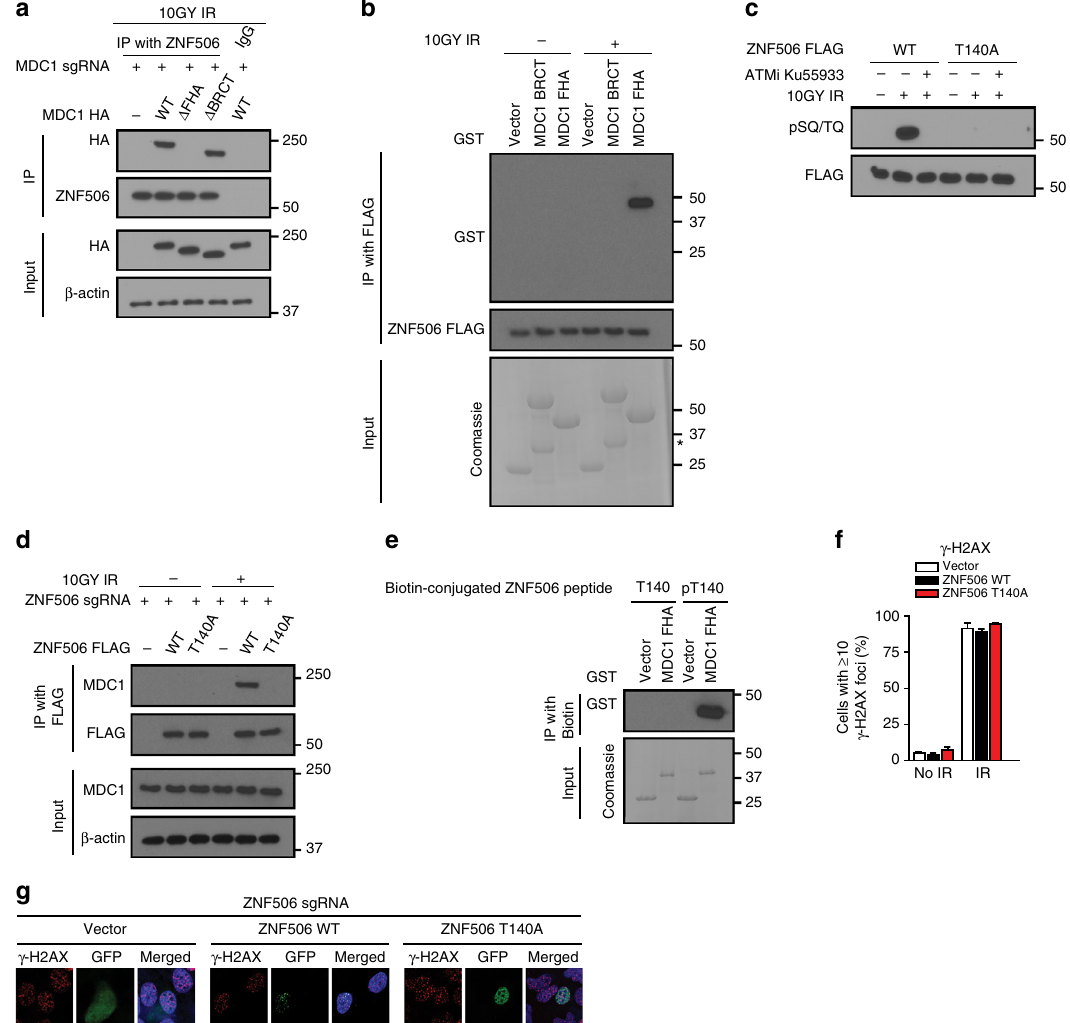
Fig. 2 DNA damage-induced ATM-dependent phosphorylation of ZNF506 is required for its MDC1-mediated recruitment to the DNA double-strand break site. a ZNF506 interacts with the FHA domain of MDC1 upon DNA damage. Deletion of the FHA domain ( Δ FHA) abrogates the interaction between MDC1 and ZNF506 in HEK293 cells. MDC1 knockout cells were transfected with the indicated plasmids and exposed to radiation. An hour later, interaction between endogenous ZNF506 and MDC1 fragments were assessed. b ZNF506 interacts with the FHA domain of MDC1 in vitro. c ATM phosphorylates ZNF506 at the T140 residue in HEK293 cells following DNA damage. ATM inhibitor (ATMi) KU55933 was used as a control. Cells were transfected with the indicated tagged constructs, co-immunoprecipitation was performed, and the blot was probed with pSQ/TQ antibody. d Phosphorylation of ZNF506 is required for its interaction with MDC1. Endogenous ZNF506 was knocked out in HEK293 cells using CRISPR and the indicated FLAG-tagged constructs were expressed. Cells were exposed to the indicated doses of radiation. Lysates were collected after an hour and immunoprecipitation with FLAG was performed. Blots were probed with the indicated antibodies. e The FHA domain of MDC1 directly interacts with phosphorylated ZNF506. The indicated peptides of ZNF506 (T140 (control) and pT140) were incubated with GST control vector or GST-tagged FHA domain of MDC1. The blot was probed with the indicated antibody. f , g Phosphorylation of ZNF506 is required for its recruitment to DNA double-strand break sites in U2OS cells. Mutation of the phosphorylation site on ZNF506 abrogates its localization to DSB sites. Cells were exposed to 2 Gy irradiation (IR) and stained for the indicated foci (red). Nucleus is stained with DAPI (blue). f Quanti fi cation of the indicated foci in U2OS cells after the indicated treatment. g Representative images of the indicated foci in U2OS cells an hour after 2 Gy IR. Shown are the representative data (mean ± SEM) from three independent experiments in f . Representative images of three independent experiments are shown in g . Scale bars, 10 µ m. Representative western blots in a – e are provided from three biologically independent experiments. Unprocessed blots are provided in Supplementary Fig.